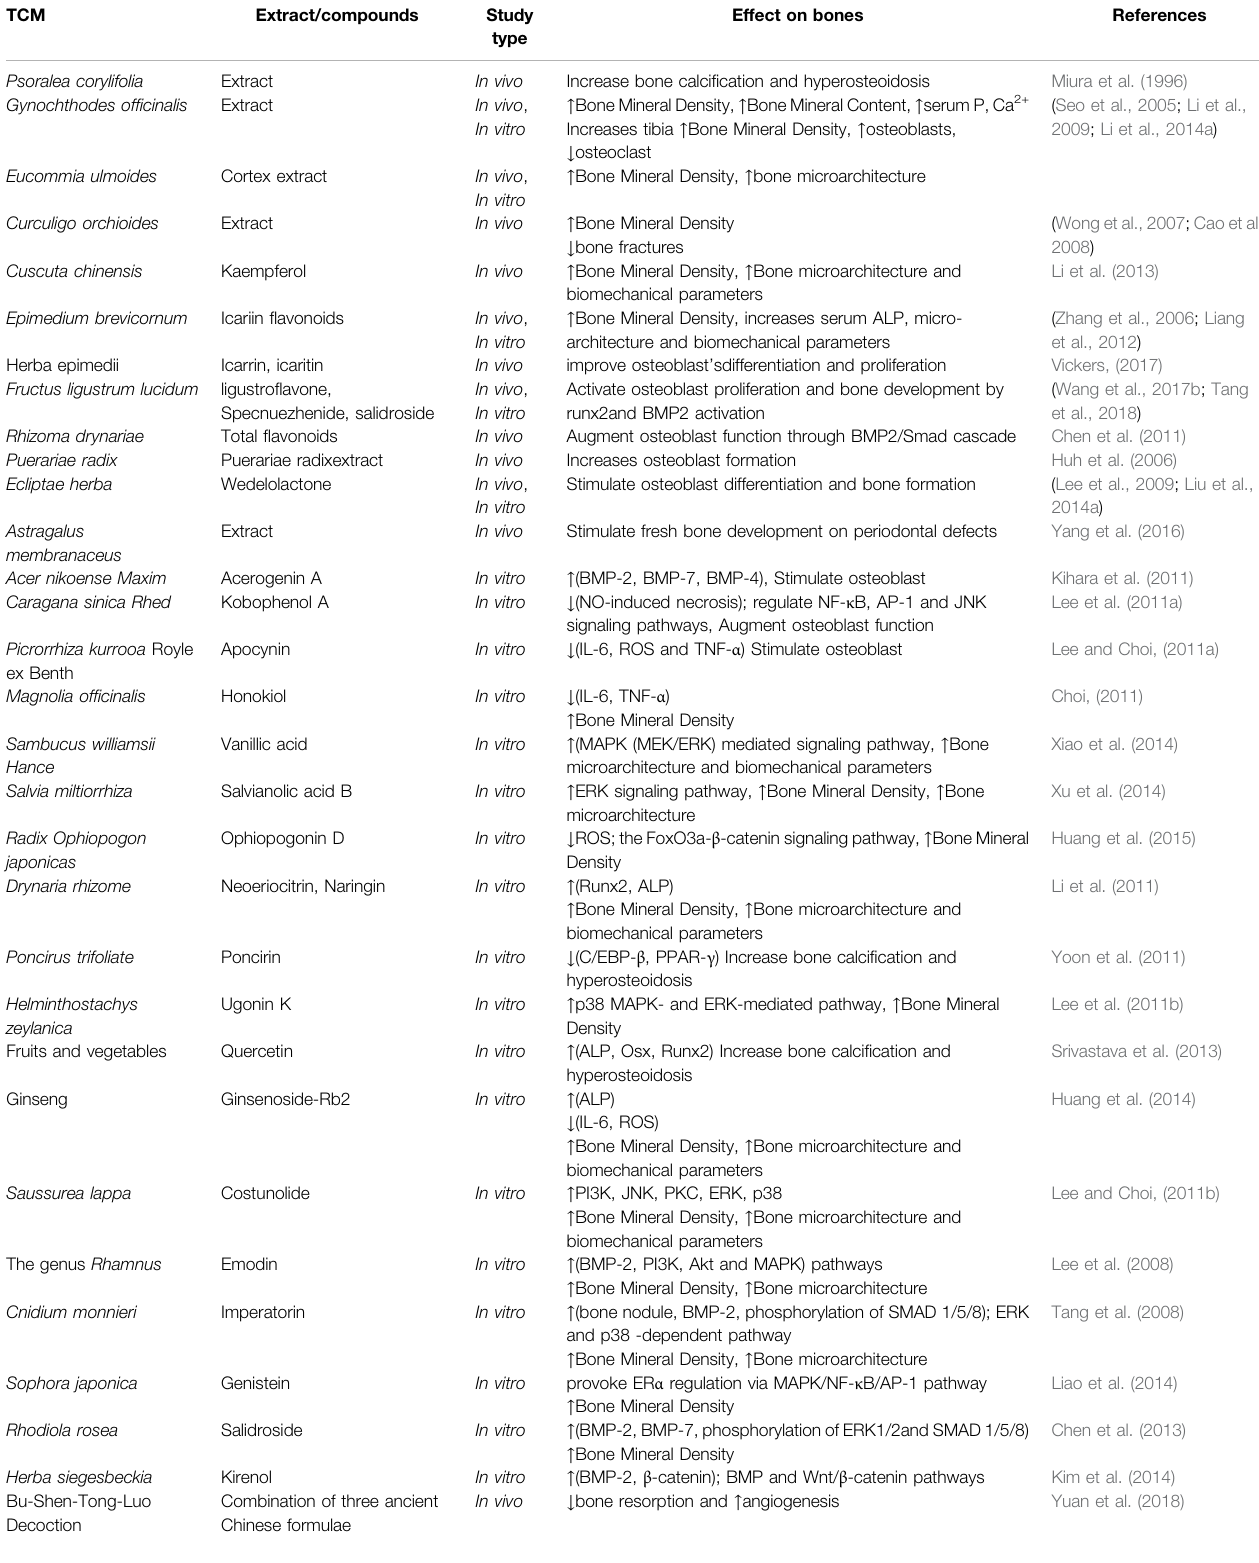
TABLE 1 | Summary and mechanism of Traditional Chinese medicines (TCM) used for bone regeneration and